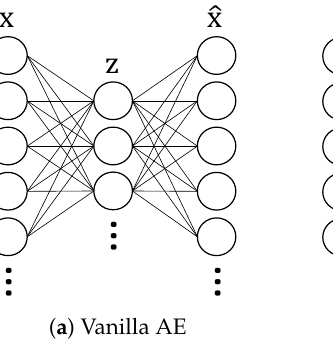
Figure 1. Illustrations of auto-encoder (AE)